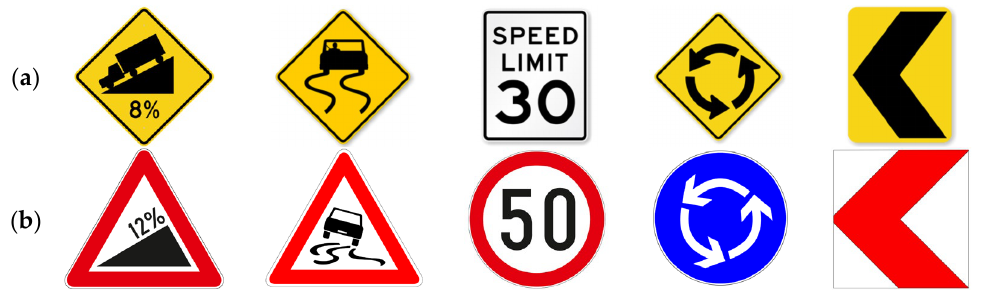
Figure 1. Comparison of road sign designs from ( a ) the United States (MUTCD system) and ( b ) Croatia (Vienna Convention-based system).